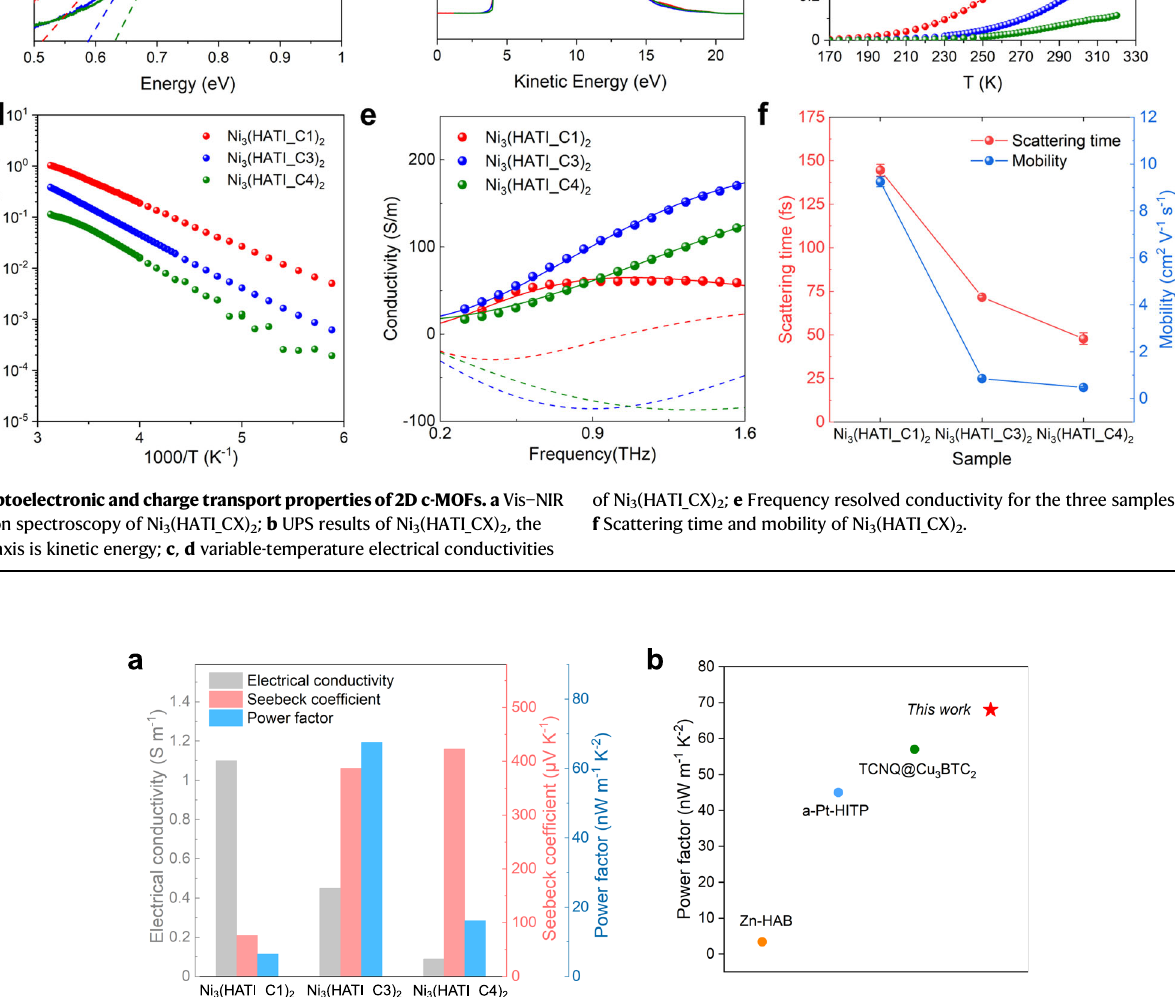
factor)ofNi 3 (HATI_CX) 2 pelletsmeasuredundervacuumat300K; b Powerfactors of Ni 3 (HATI_C3) 2 compared with other p -type thermoelectric MOFs.